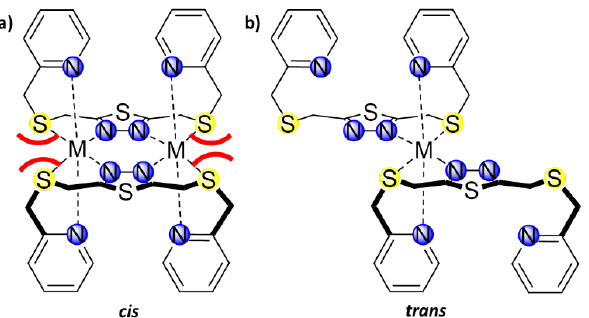
Figure 5. Schematic representation of the two coordination modes for the sulphur donor atoms. ( a ) The sulphur donor atoms are coordinating cis to each other, which is necessary to obtain dinuclear complexes. ( b ) The sulphur donor atoms are coordinating trans to each other, as described for the mononuclear complexes